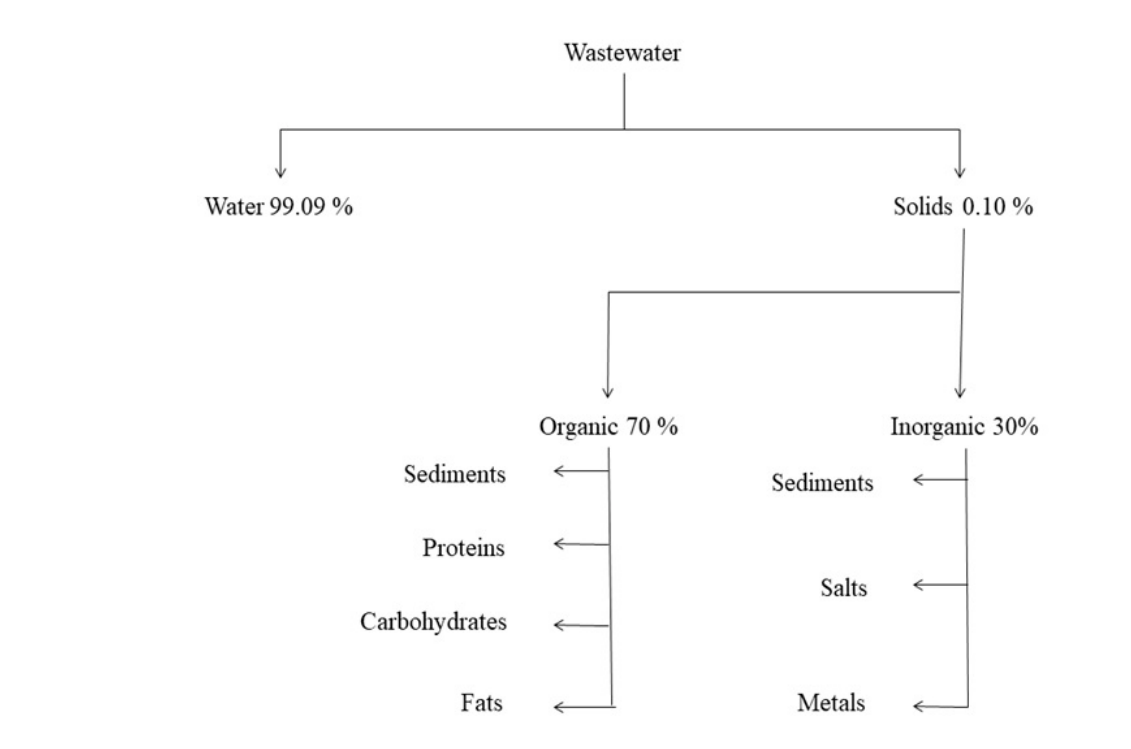
Figure 1. Various sources of wastewater.